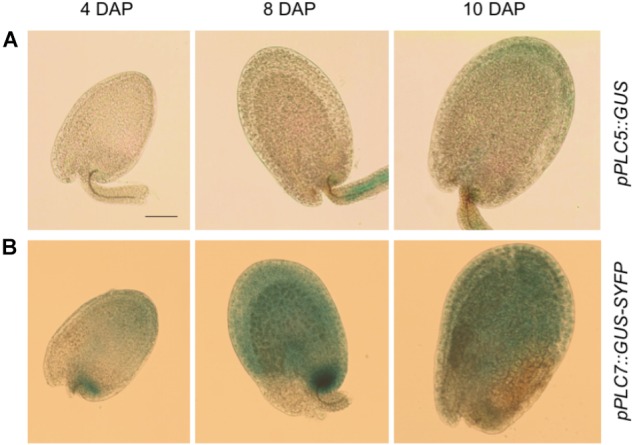
PLC5 and PLC7 expression during seed development. (A) GUS activity analysis in pPLC5::GUS-developing seeds. Expression was found in the funiculus at 8 days after pollination (DAP) and in the seed coat at 10 DAP. (B) GUS activity analysis in pPLC7::GUS-SYFP-developing seeds. Staining was found in the chalazal and seed coat. Representative results of 3 independent experiments are shown. Bar = 0.1 mm.